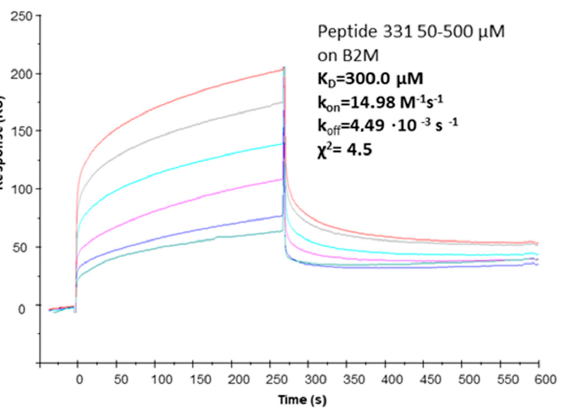
Figure 4. Overlap between peptides/ β 2m configurations as obtained by the design algorithm: ( a ) side and ( b , c ) top views. Color code: β 2m (blue), peptide pep381 designed for site A (cyan), and peptide pep331 designed for site B (pink). Both peptides are cyclic thanks to an intramolecular S-S bridge (yellow). β 2m size along selected directions is also